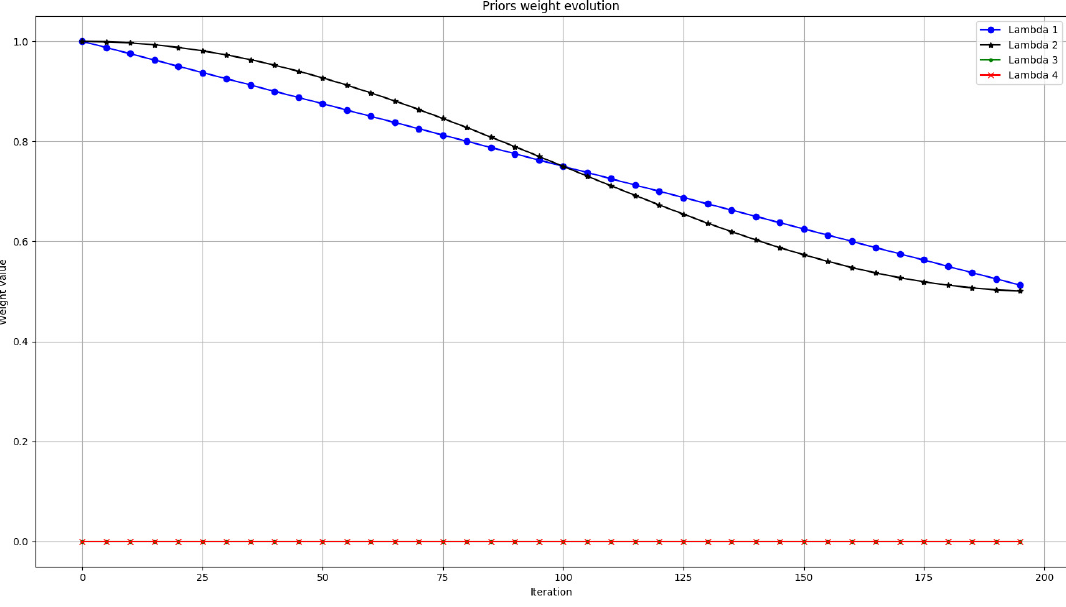
Figure 5. Evolution of λ i weights for the energy